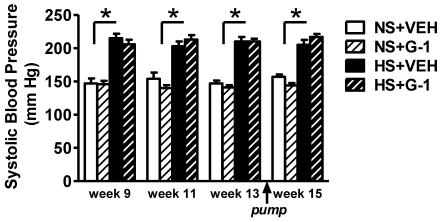
G1 treatment for two weeks does not affect salt-associated increases in blood pressure.Tail-cuff systolic blood pressure in conscious female mRen2.Lewis rats fed a normal salt (NS) or high salt (HS) diet over the course of the experiment. Arrow indicates time of pump insertion for 14-day delivery of either G-1 or vehicle (VEH). Values are mean ± SEM; * P<0.05 compared to NS (Salt effect).